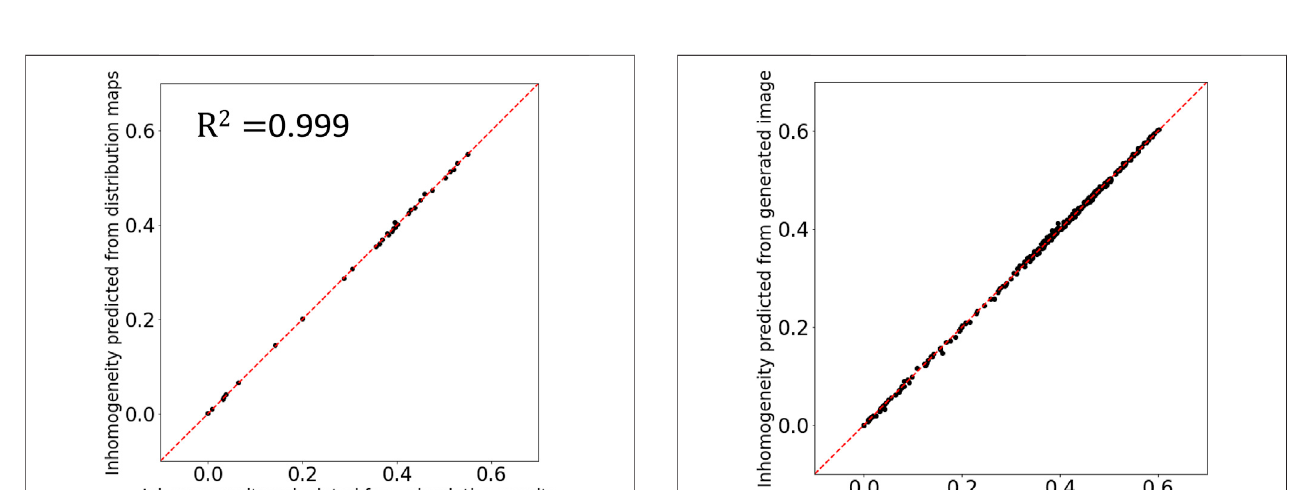
FIGURE7| Comparison ofthe inhomogeneity ofthedensity between thehigh-resolutiongrid cases and the low-resolution grid cases forthe training datasets. (A) The inhomogeneities for all time-series and all magnetic fi eld strength cases are plotted. (B) The inhomogeneities for T ≥ 0.12 and B 0 ≥ 0.6 are plotted.